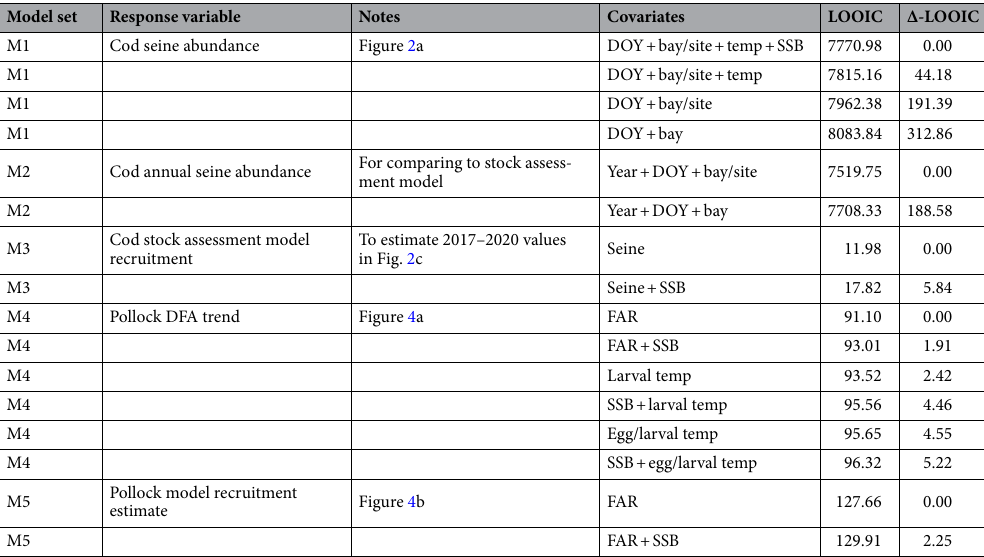
Table 1. Model selection results. DOY day of year, SSB spawning stock biomass, temp egg/larval temperature, FAR fraction of attributable risk, LOOIC leave one out information criterion, Δ-LOOIC LOOIC difference from best